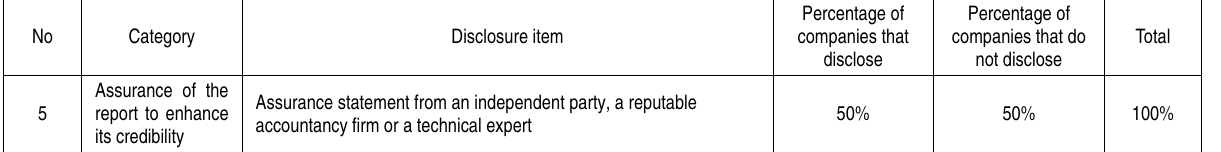
Table 3. Disclosure of an assurance statement in the environmental